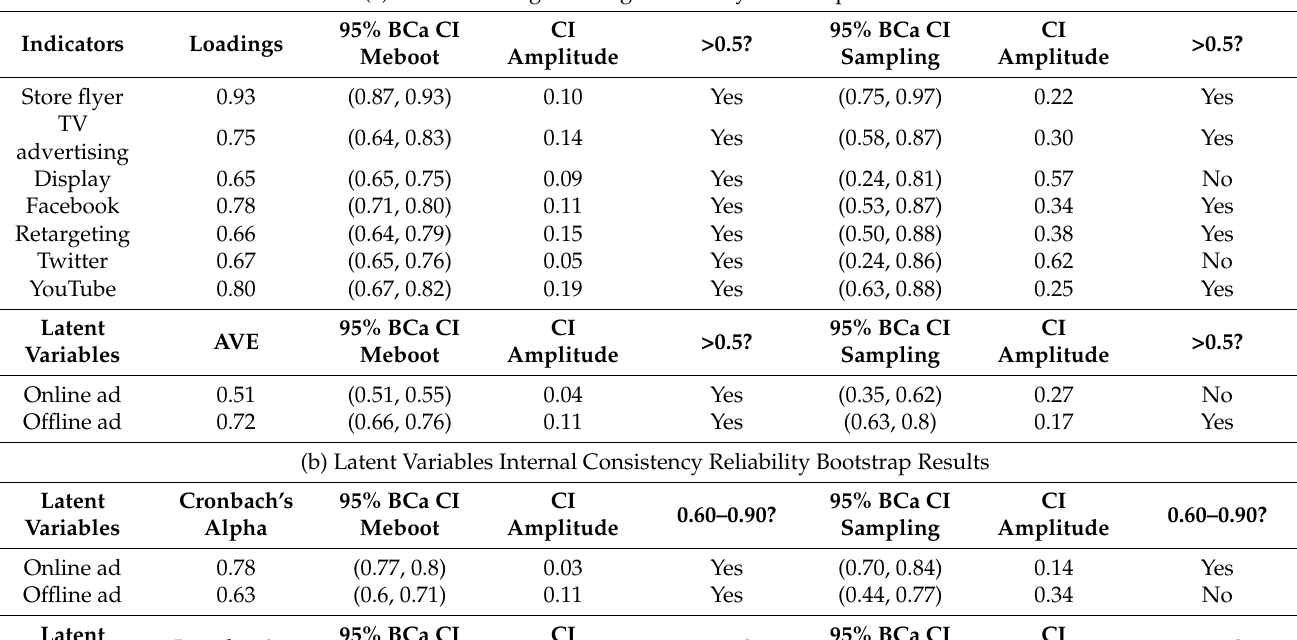
Table 3. Assessment of the reflective measurement model latent variables by meboot and sampling bootstrapping. ( a ) Con- vergent validity of the outer model. ( b ) Reliability of the outer model. ( c ) Discriminant